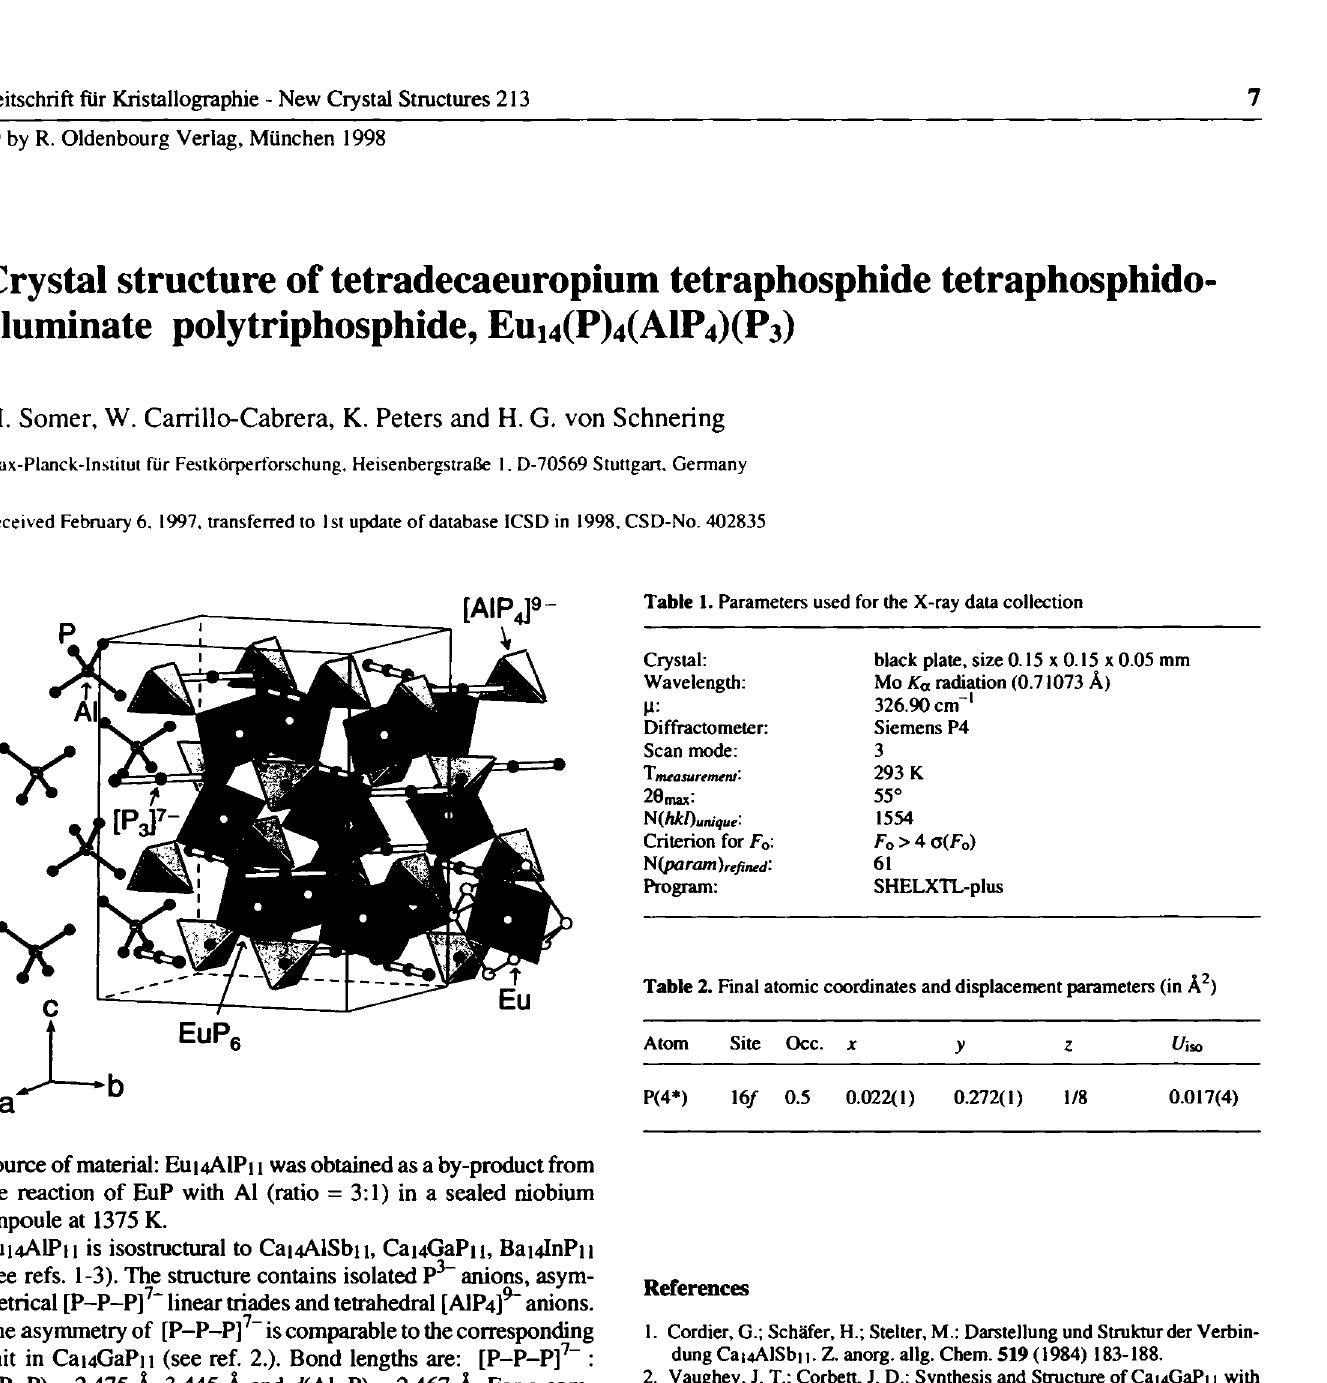
Table 3. Final atomic coordinates and displacement parameters (in Â^)